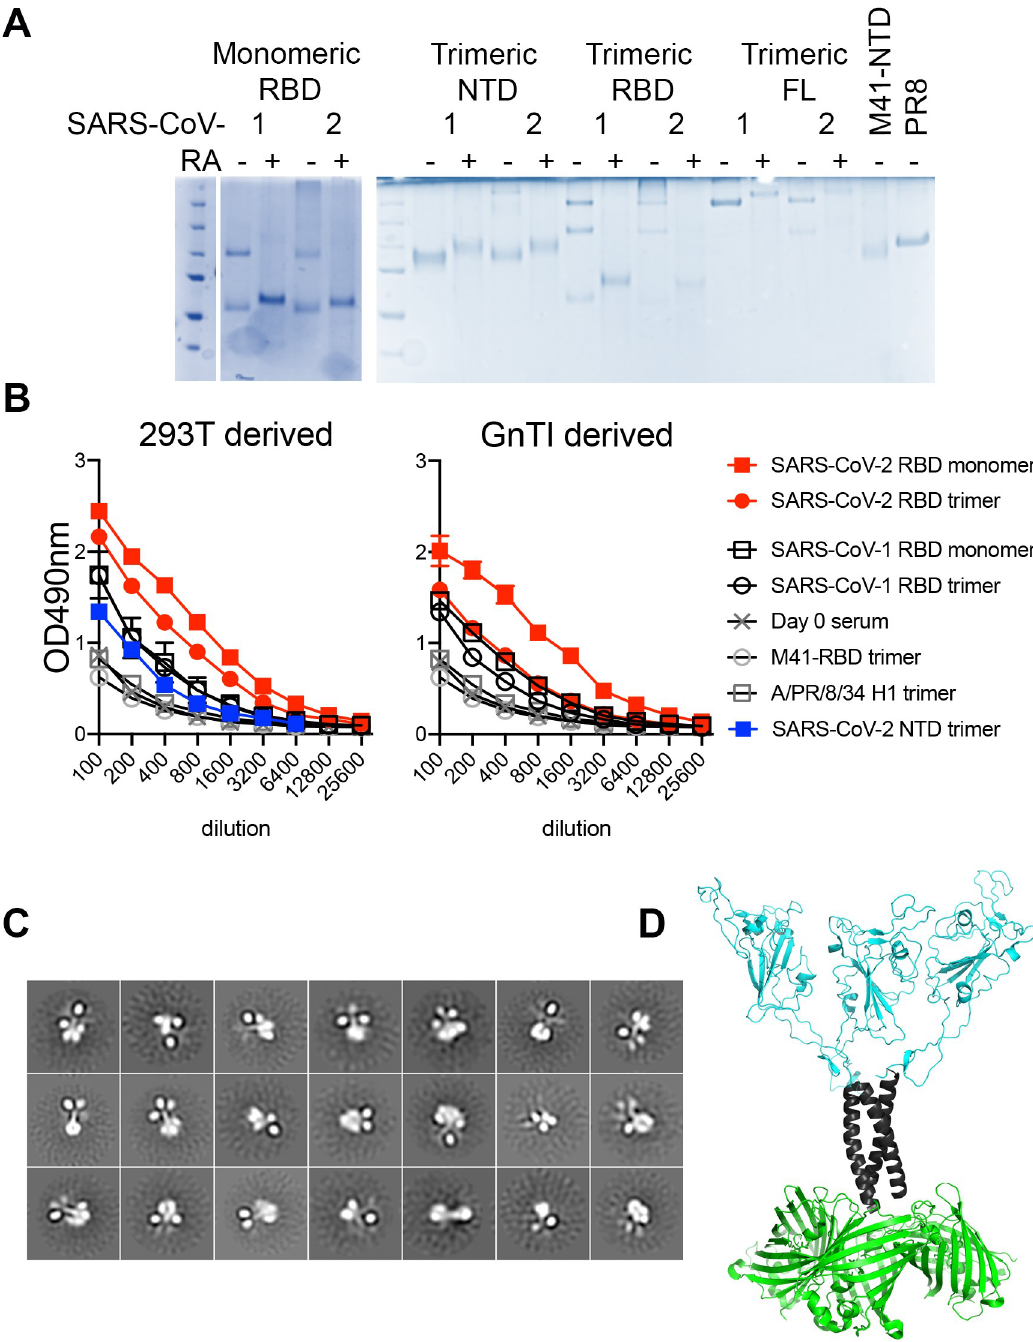
Fig 2. Molecular analyses. (A) SDS-PAGE analyses of purified RBD proteins. 500 ng of purified proteins were loaded on a gel with or without preheating for 30 minutes at 98C in the presence of a reducing agent. (B) Antigenic analyses using 21-day post- infection macaque serum. 2 μ g/ml SARS-CoV-RBD proteins were coated on 96-well plates. Proteins were detected with macaque serum for 2hrs at RT. An anti-human IgG-HRP was used to detect RBD specific antibodies. Both 293T and GnTI -/- derived proteins were analyzed. As negative controls, IBV-M41-NTD and HA-PR8D were included. (C) Negative stain EM of trimeric RBD fused to sfGFP. Negative-stain 2D class averages of soluble RBD proteins demonstrate that they are well-folded trimers. The C-terminal helices and fusion proteins are visible in some class averages. (D) Structural model. Based on the crystal structure of a SARS-CoV-2 RBD in the up conformation, with a GNC4 trimerization domain with 3 sfGFP domains added.